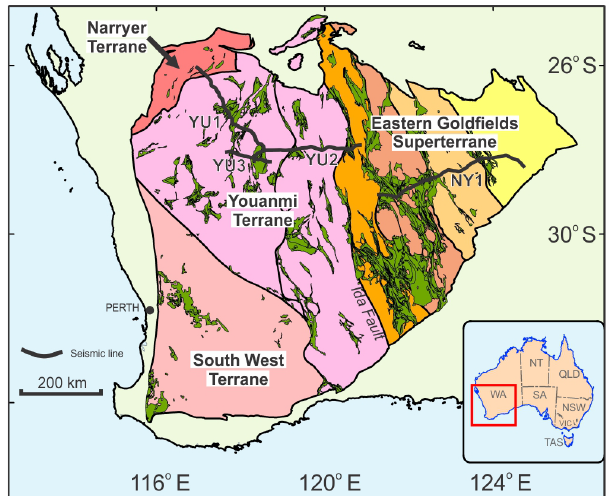
Figure 1. Major terranes of the Yilgarn Craton in Australia with locations of deep seismic lines. The Youanmi Terrane represents the older core of the craton to which terranes of the Eastern Gold- fields Superterrane were accreted during the late Archean. Green- stone belts are shown in